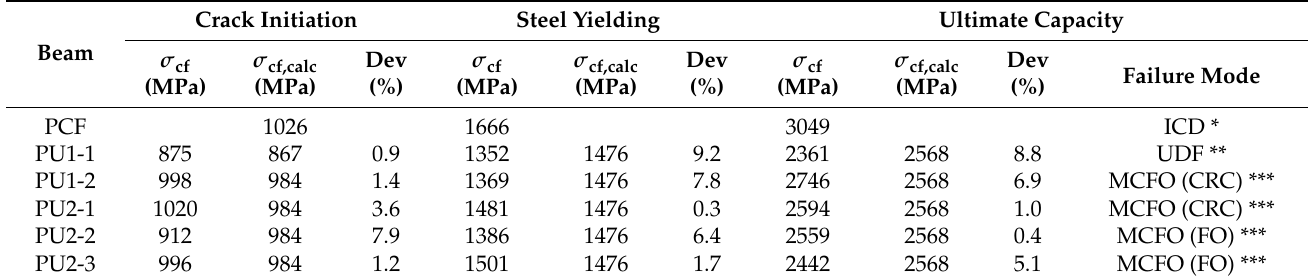
Table 8. CFRP stress predictions and test